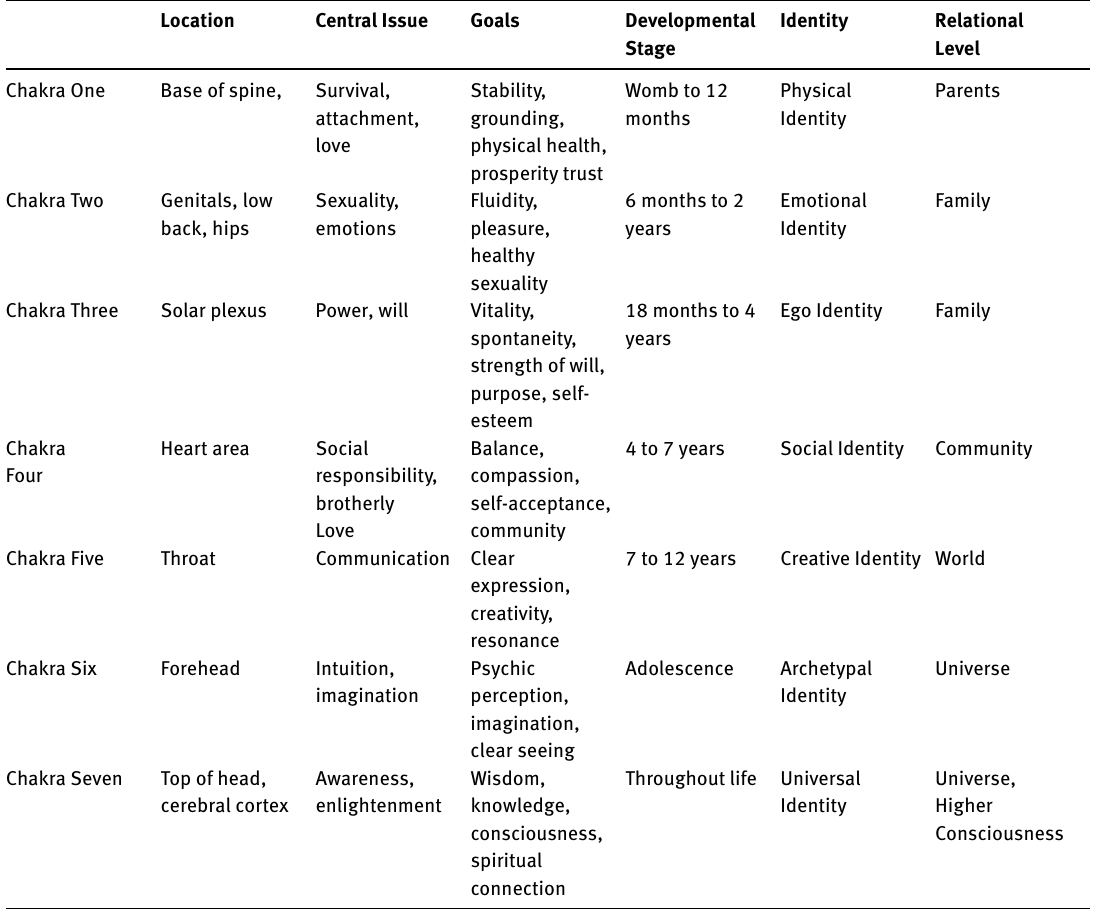
Table 1. The Qualities and Characteristics of the Chakras